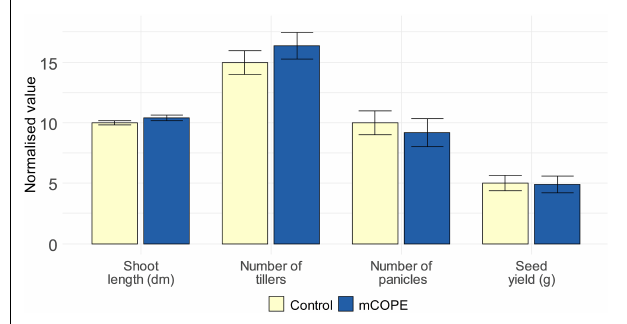
FIGURE 5 | Repetitive treatments with Cucurbitaceae COld Peeling Extract (CCOPE) derived from melon ( Cucumis melo var. cantalupensis ; mCOPE) do not affect rice growth or development. Rice plants were grown under greenhouse conditions and foliarly treated on a biweekly basis with the buffer used for CCOPE preparation (Control) or mCOPE. The illustrated data were assessed when seeds were ready to be harvested (i.e., after a growth period of approximately 4 months). Error bars represent the standard error of the mean. No significant differences were detected upon comparison of mCOPE-treated plants with mock-treated control plants using a two-sided heteroscedastic t -test ( p <